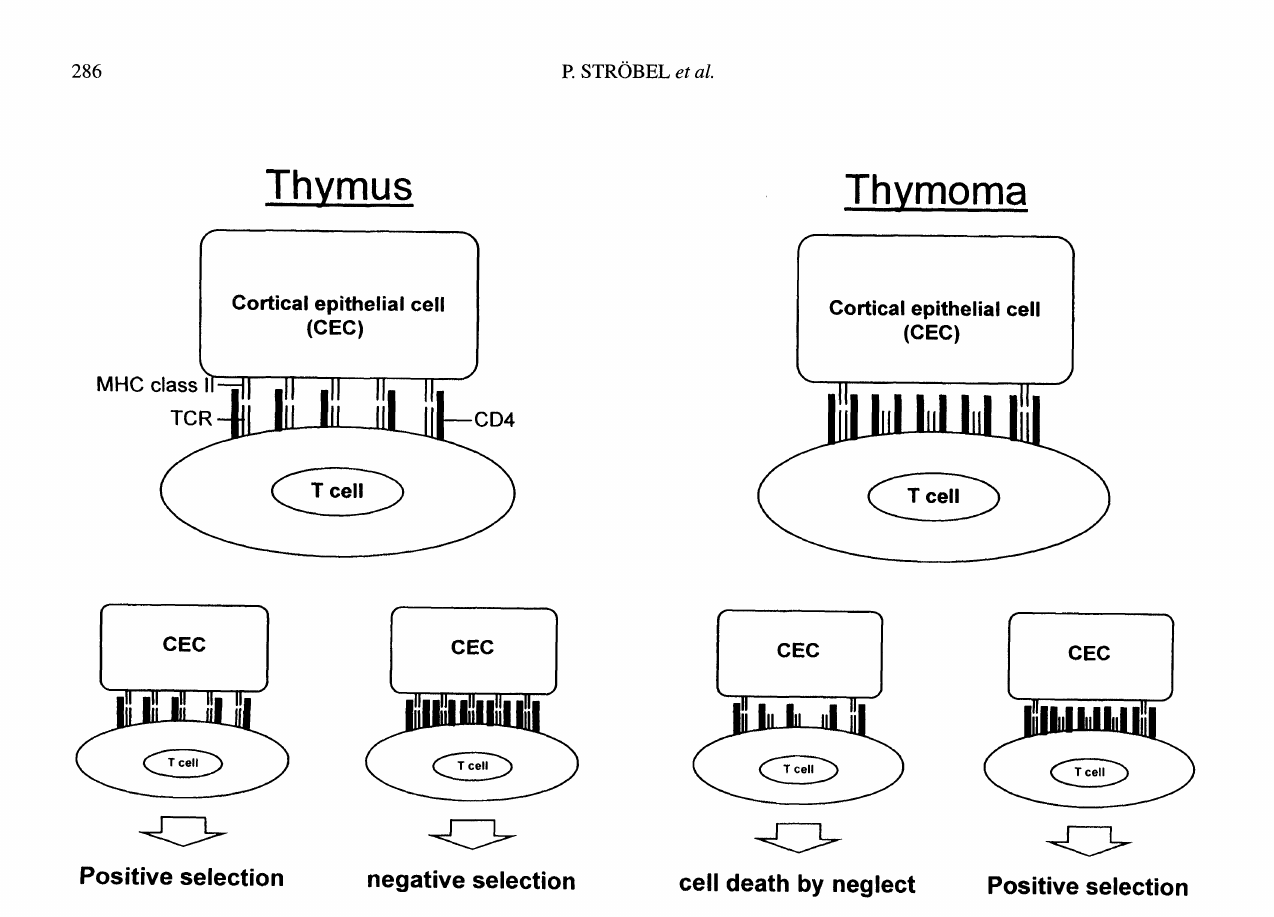
cell death by neglect Positive selection FIGURE 4 Potential selection advantage for pre-selection thymocytes with increased surface CD4 levels in thymomas with decreased MHC class II expression. In a micromilieu with low epithelial class II levels, upregulation of CD4 could convey a positively selecting signal, which under normal conditions would lead to the elimination (negative selection) of the cell. As the affinity required for positive selection is well below the affinity inducing negative selection, positively selected, autoreactive T cells might escape thymic deletion. Of note, CD4 upregu- lation was measured as median surface level and thus only a subset in a given thymocyte population in thymomas showed this